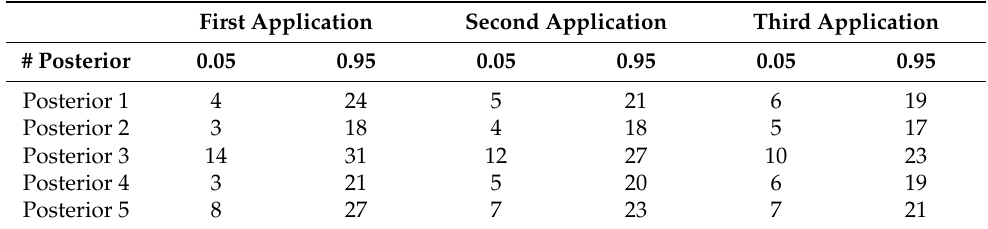
Table 6. Number of failures corresponding to a cumulative probability of 0.05 and 0.95 (considering 40 observations in the future sample).